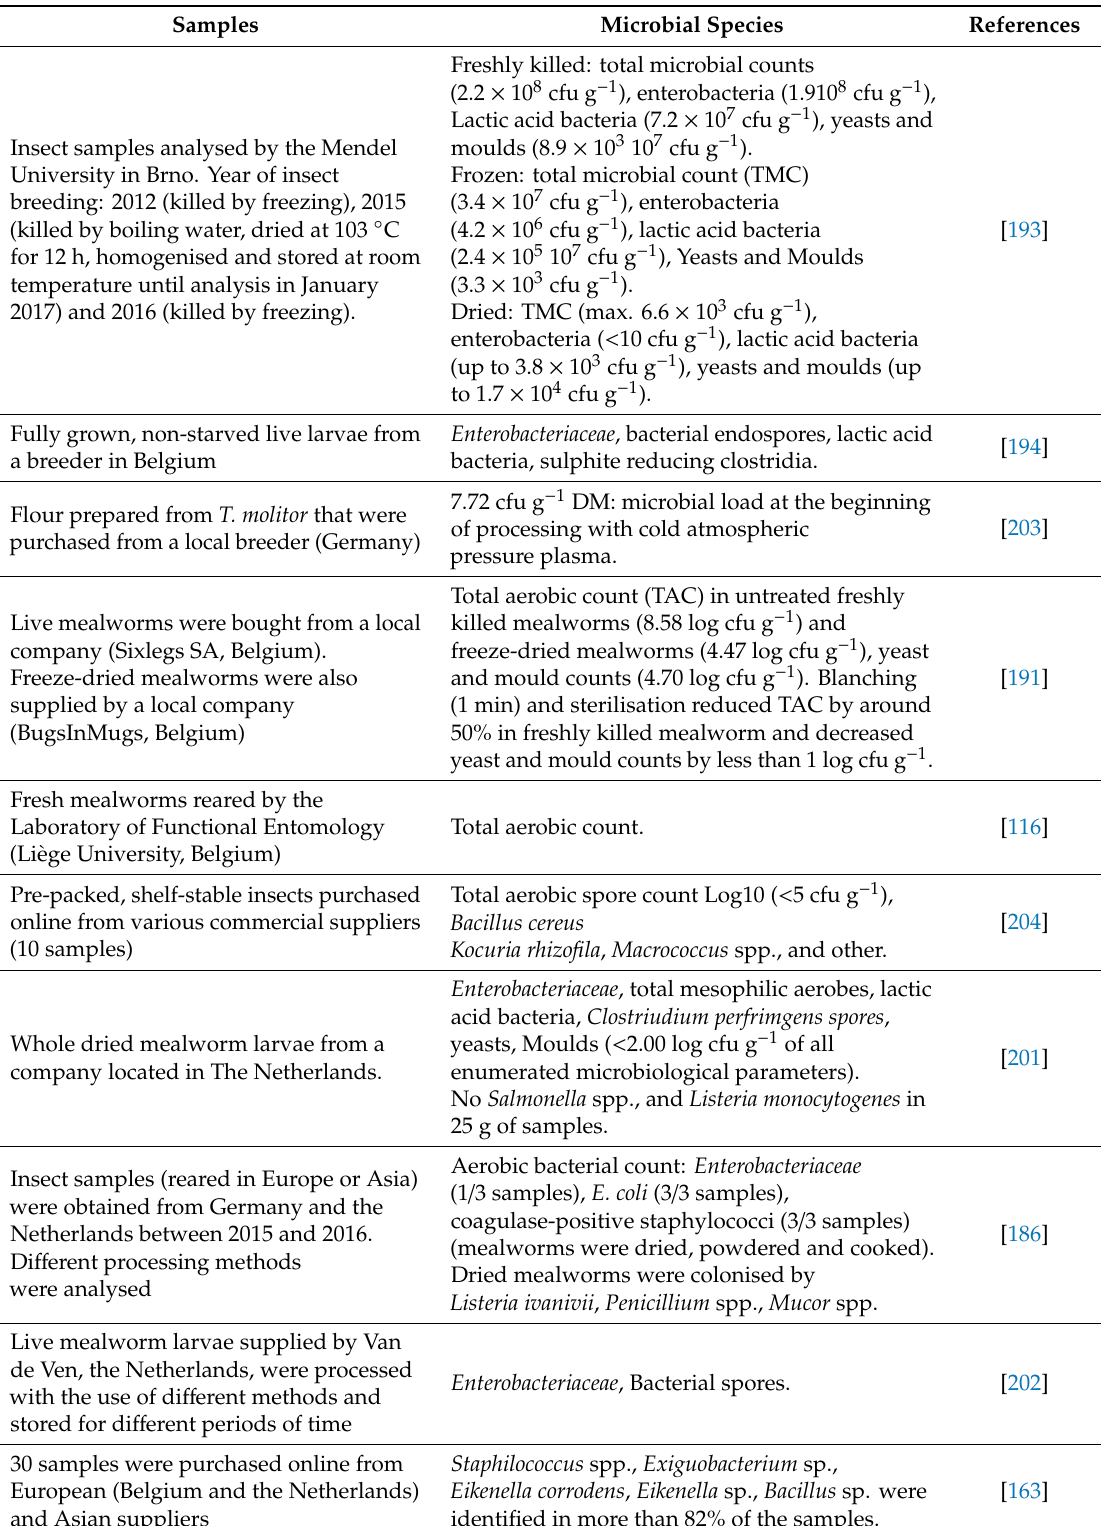
Table 7. Microbial load of mealworm larvae from di ff erent breeders and